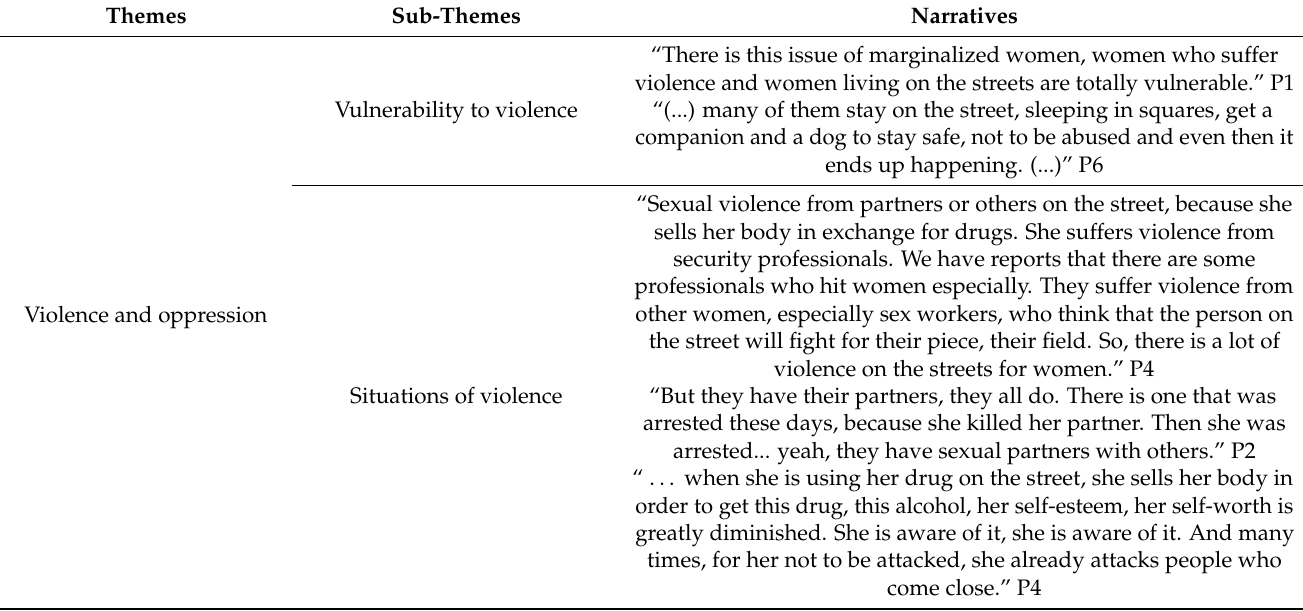
Table 1. Workers’ narratives related to violence against homeless